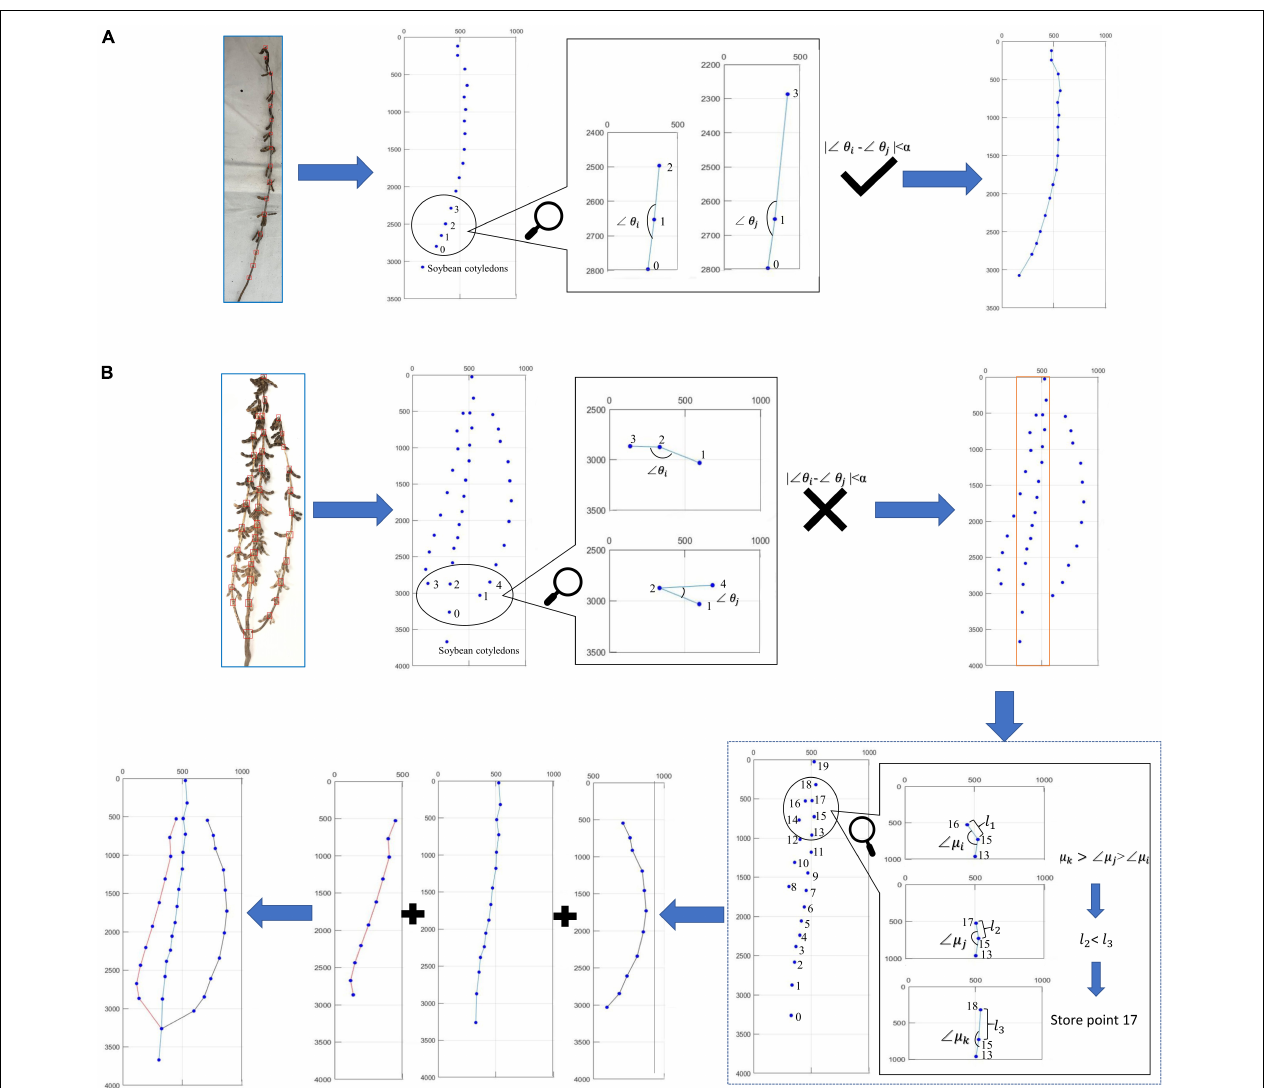
FIGURE 5 | Judgment process of algorithm on actual soybean plant: (A) single-branch judgment process and (B) multi-branched judgment